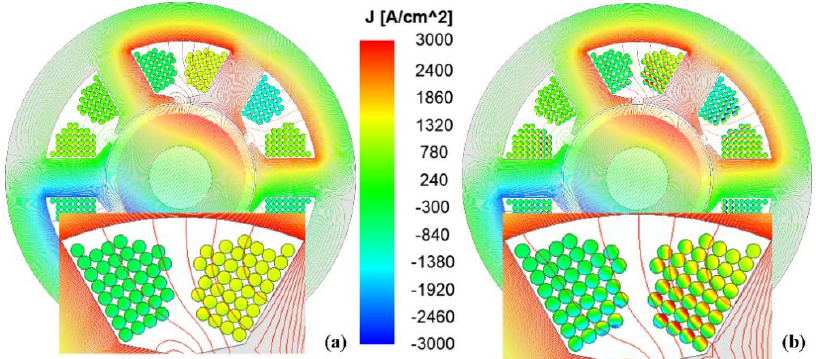
Figure 5. Distribution of magnetic flux and current density in the stator winding according to the current waveform: ( a ) sinusoidal and ( b ) PWM current.